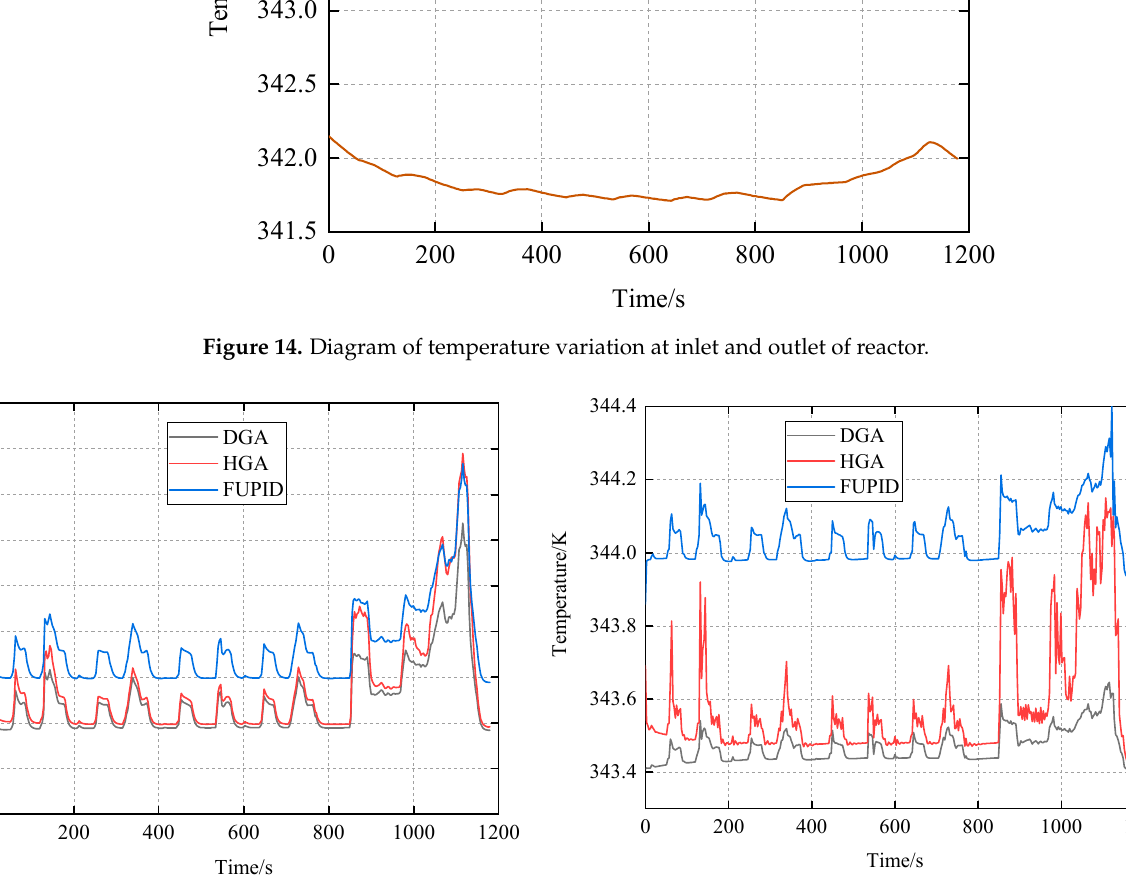
Figure 15. ( a ) MEA temperature change chart of three strategies; ( b ) Temperature variation diagram of bipolar plate with three strategies.